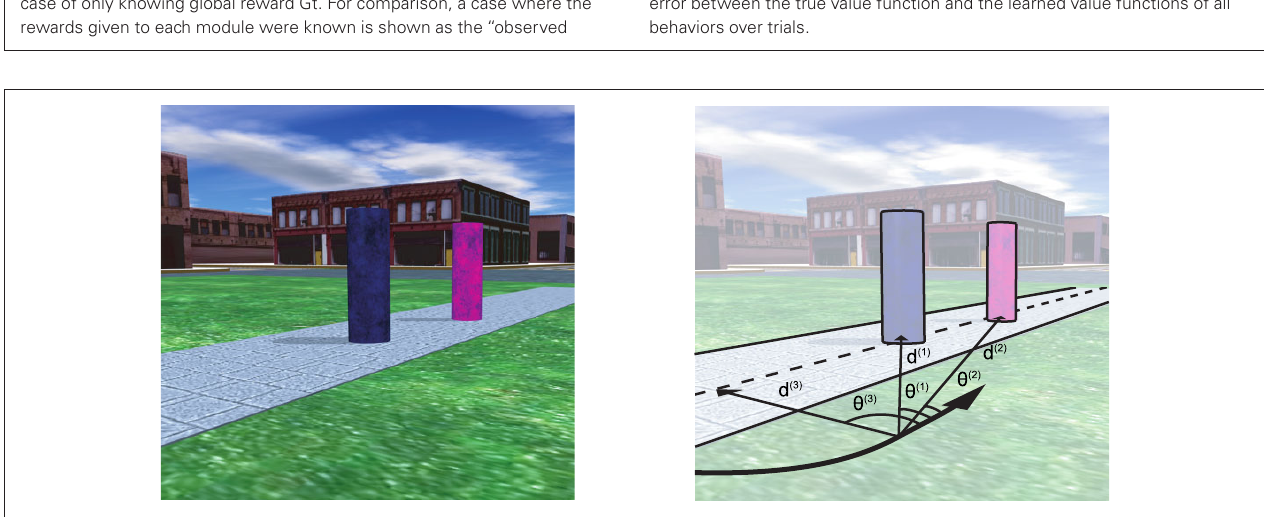
Figure 7 | The walkway navigation tasks. Left: typical view from the agent while navigating along the walkway. The three possible tasks are following the walkway, avoiding obstacles, which are the dark cylinders, and picking up litter, corresponding to the light cylinders. Right: Schematic representation of the statespace parameterization for the learners. Each module represents the